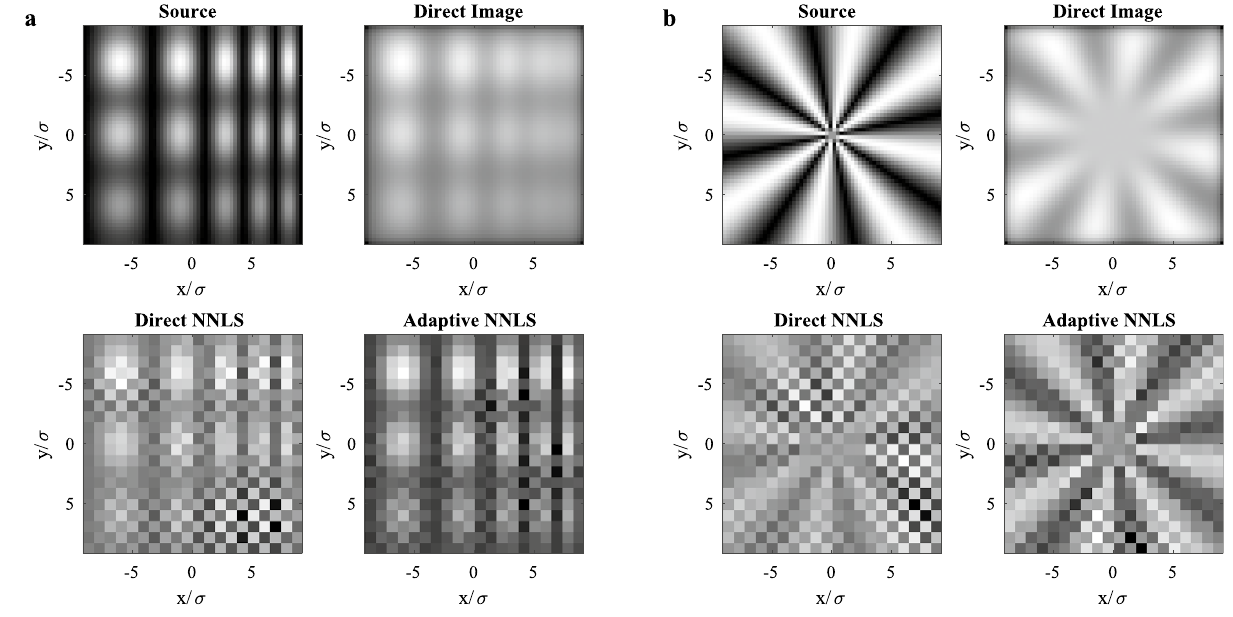
Figure 5. Adaptive imaging on low-contrast 2D sources for ( a ) a chirped source and ( b ) a Siemens star target. 13 The images correspond to � N � = 3 × 10 photons collected, and the sources have Michelson contrasts of 0.028 (chirped source) and 0.025 (Siemens star source). For the NNLS reconstructions, the chirped and Siemens star sources are discretized into square bins with a width of � x ≈ 0.9 σ . The adaptive reconstruction achieves 4.1 times lower MSE than direct reconstruction for the chirped source, and 7.2 times lower MSE for the Siemens star